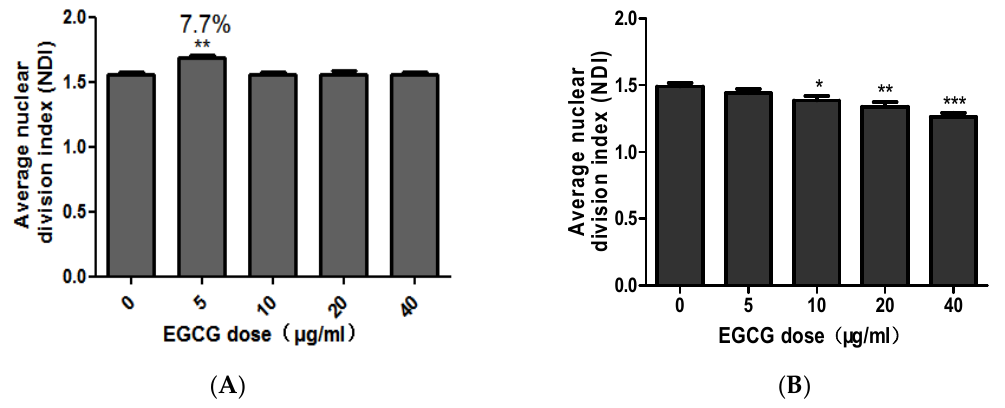
Figure 4. The combined average of the effect of EGCG on NDI in NCM460 ( A ) and COLO205 ( B ). Note: Significant differences between EGCG-treated groups and controls at each treatment interval are indicated by * p < 0.05, ** p < 0.01 and *** p < 0.001.